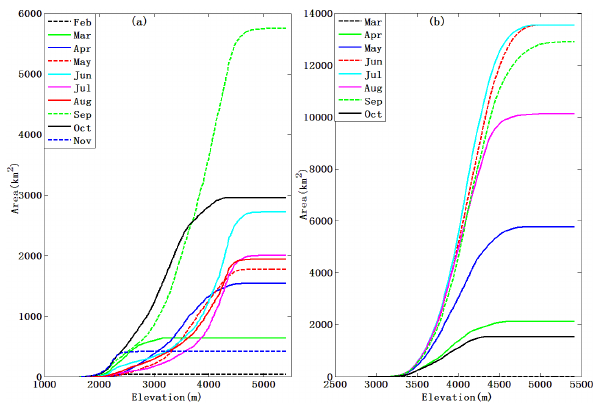
Figure 5. Altitudinal Cumulative Melt Curve: (a) cumulative monthly snowmelt area distribution by elevation (2003–2012); (b) cumulative monthly glacier melt area distribution by elevation (2003–2012). The snowmelt areas in December and January and the glacier melt areas in November, December, January, and February are zero and are not shown in this